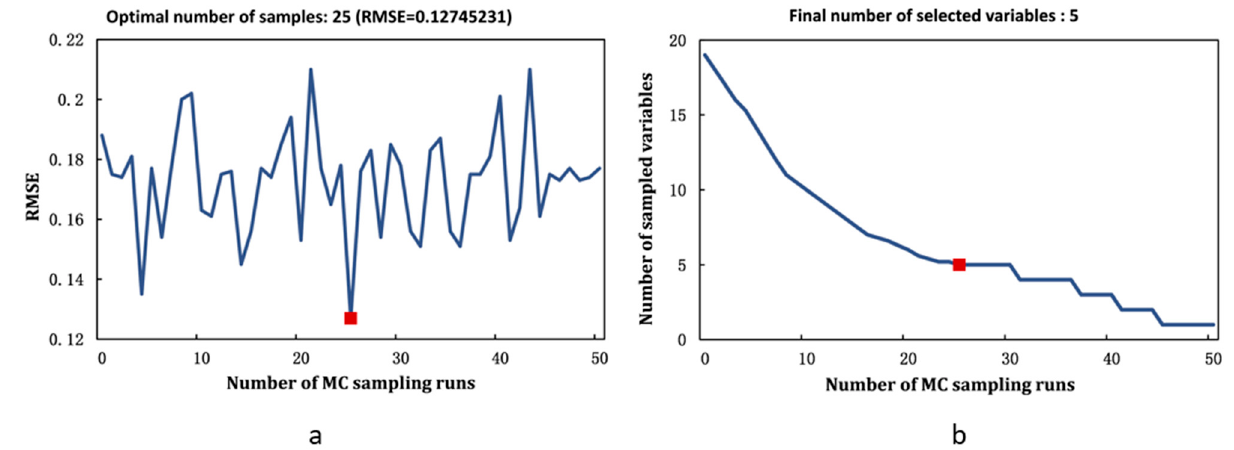
Figure 10. Process of variable extraction by CARS. ( a ) The variation of RMSE. ( b ) The selection of the optimal number of variables.